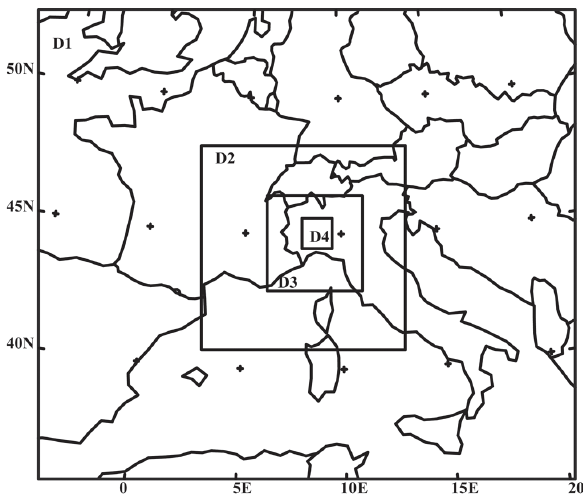
Fig. 3. Four two-way nested domains of the MM5 model at 27km, 9km, 3km, and 1km horizontal